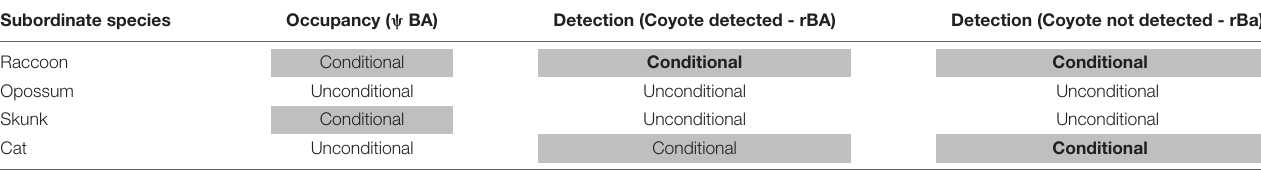
TABLE 3 | Predicted two-species occupancy model conditionality for dominant coyotes versus subordinate mesopredator species based on top detection and occupancy model configurations. Subordinate